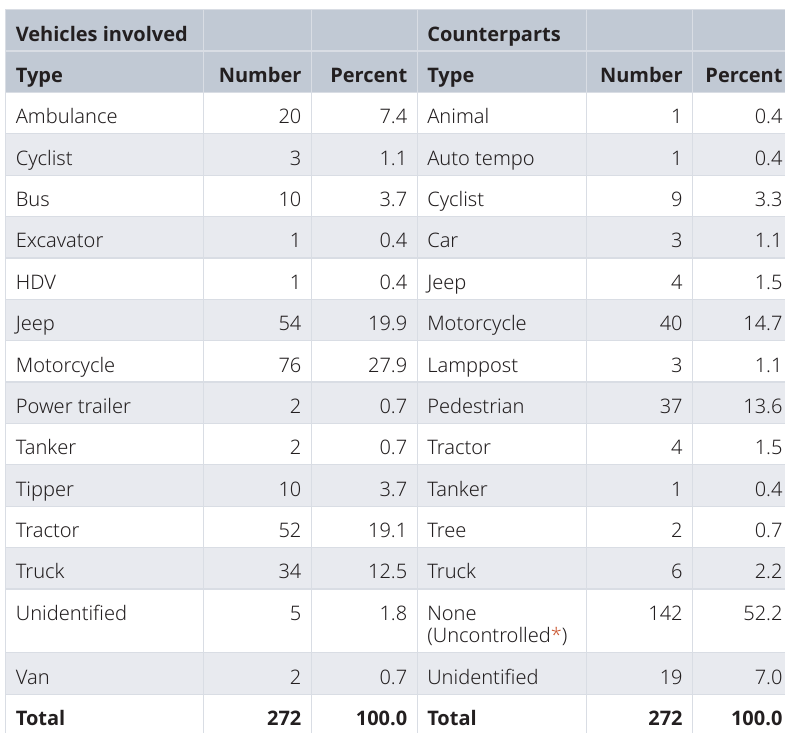
Table 3. Distribution of road crashes during national level COVID-19 lockdown in Nepal according to the types of vehicles involved and their